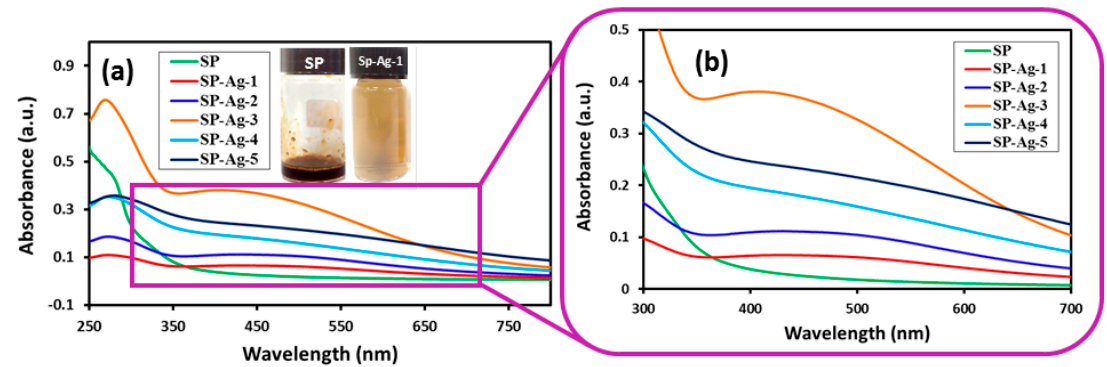
Figure 2. ( a ) UV-Vis spectra of pure S. persica L. RE (SP, green line). SP-Ag-1 (red line), SP-Ag-2 (blue line), SP-Ag-3 (orange line), SP-Ag-4 (cyan line), SP-Ag-5 (dark blue line), are the UV spectra of pure Ag-NPs prepared with 0.1 mL, 0.5 mL, 1.0 mL, 2.0 mL, and 3.0 mL RE, respectively; ( b ) Magnified image of Figure 2a. All the reactions were carried out for a period of 2 h, and the samples for the UV measurements were taken after final workup.